Question: In a single sentence, describe what this figure presents.
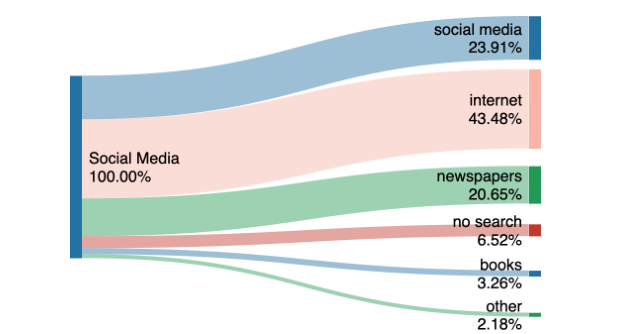
Answer: Distribution of information sources chosen during the Perception phase for the participants that answered so- cial media to question 1.3 of the Background phase.